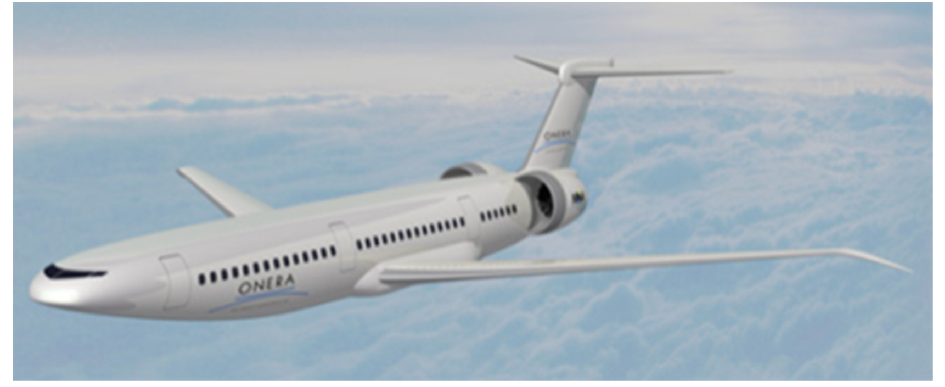
Figure 14. ONERA NOVA Aircraft.